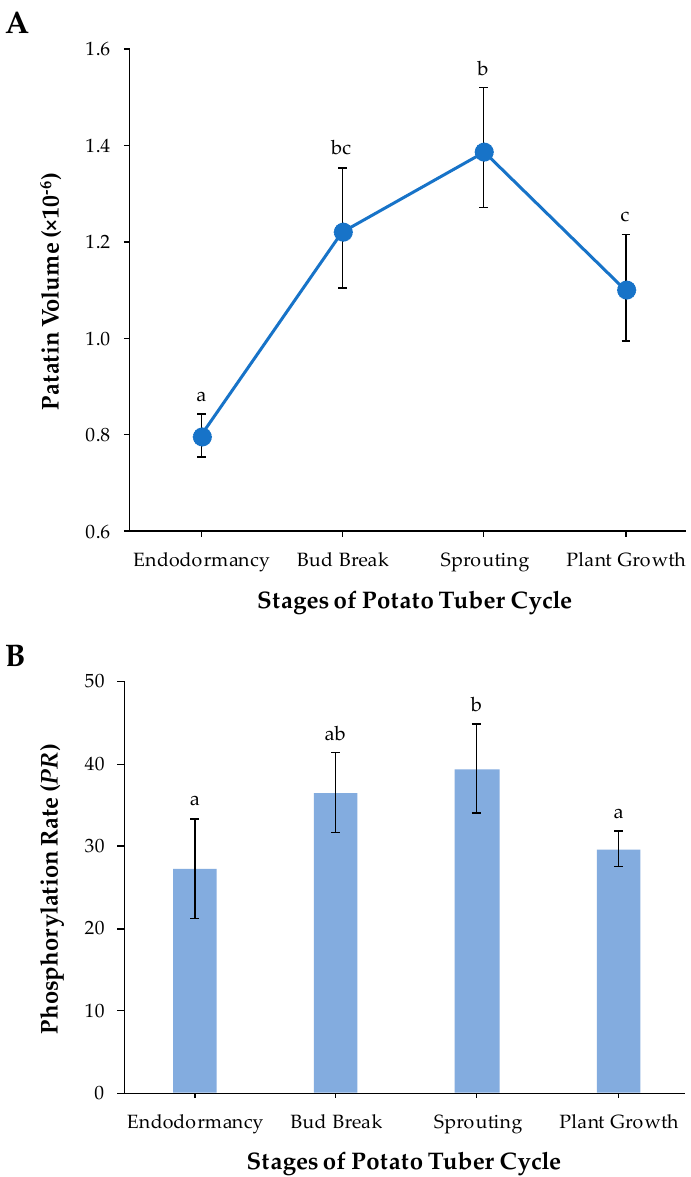
Figure 3. ( A ) Dynamic changes in the patatin abundance through the different stages of the potato tuber life cycle: endodormancy, bud break, sprouting and plant growth. In each tuber stage, mean patatin quantity over four biological replicates is represented together with their Bonferroni-corrected 95% bootstrap CIs. ( B ) Mean PR values together with their 95% confidence interval obtained from four biological replicates in endodormancy, bud break, sprouting and plant growth potato tuber stages of the Kennebec cultivar. Different lower case letters (a–c) indicate statistically significant differences ( p < 0.05) between sample groups by the post hoc Tukey-Kramer test following the one-way analysis of variance (ANOVA) test.